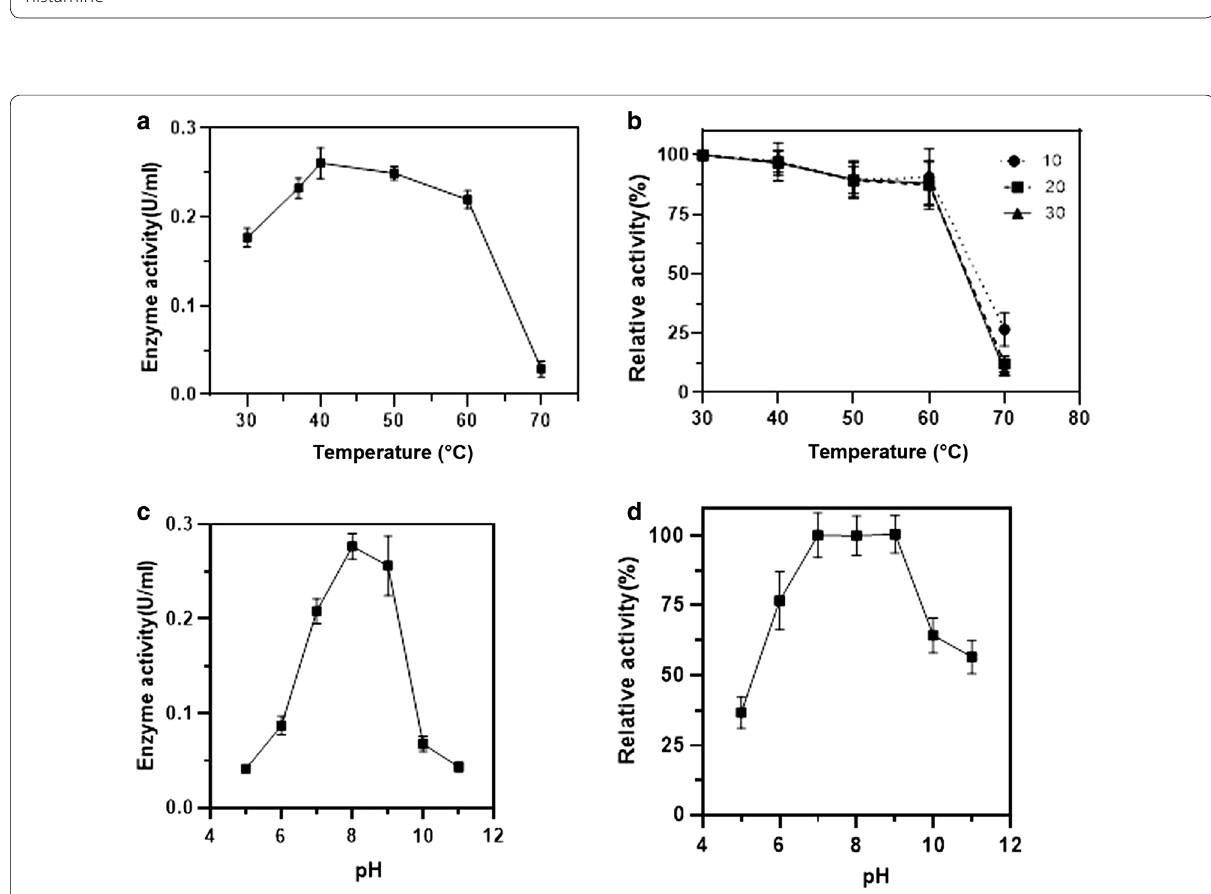
Fig. 5 a Temperature profile, b thermal stability, c pH profile, and d pH stability of HOD from Glutamibacter sp. N1A3101. Thermal stability was measured after incubation of HOD for 10, 20, and 30 min at temperatures 30–70 °C, and pH stability measured after 10 min incubation at 40 °C. Error bars represent standard error (n =